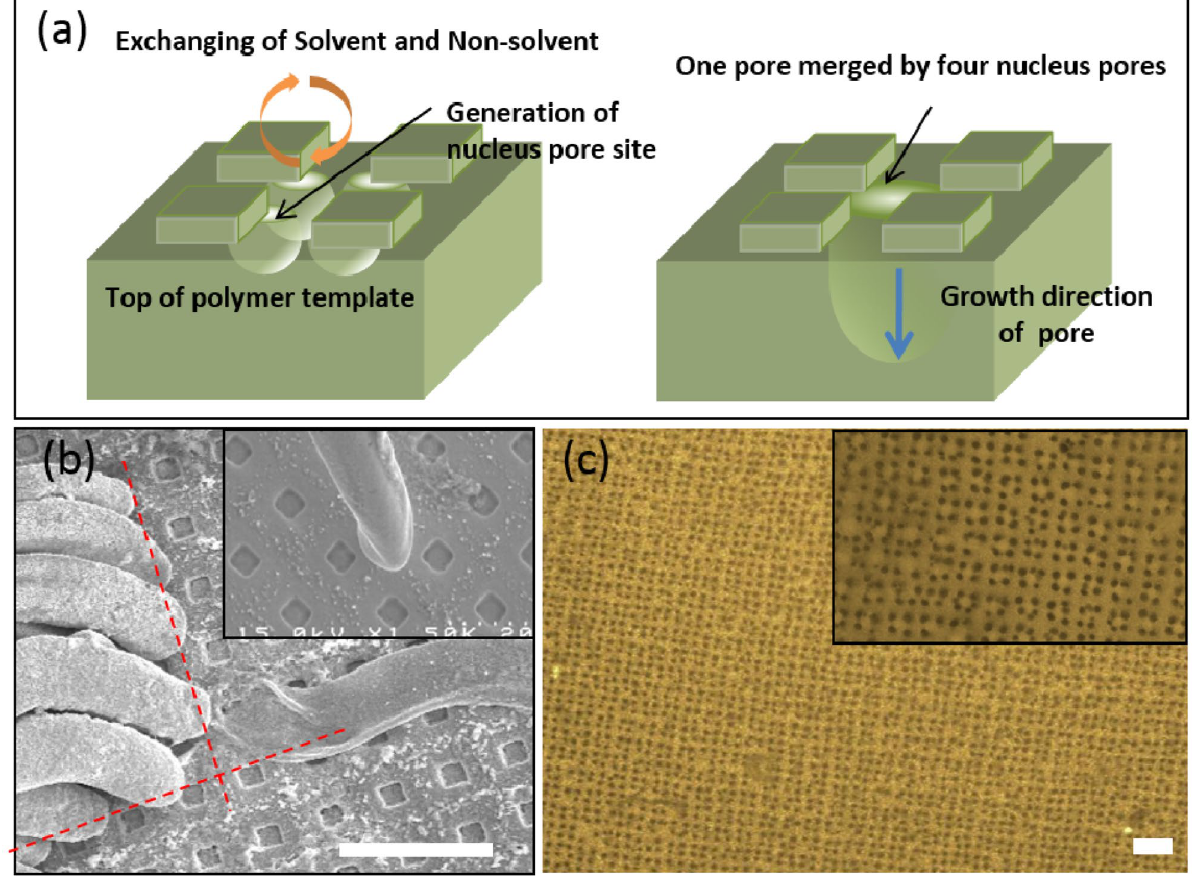
Figure 4. Schematic of mechanism and SEM images (scale bar is 20 μm): ( a ) pore generation mechanism, ( b ) a bundle of Au-capped rods (inset: single Au rod), ( c ): confocal image of nucleation pores on PEI membrane (inset: magnified